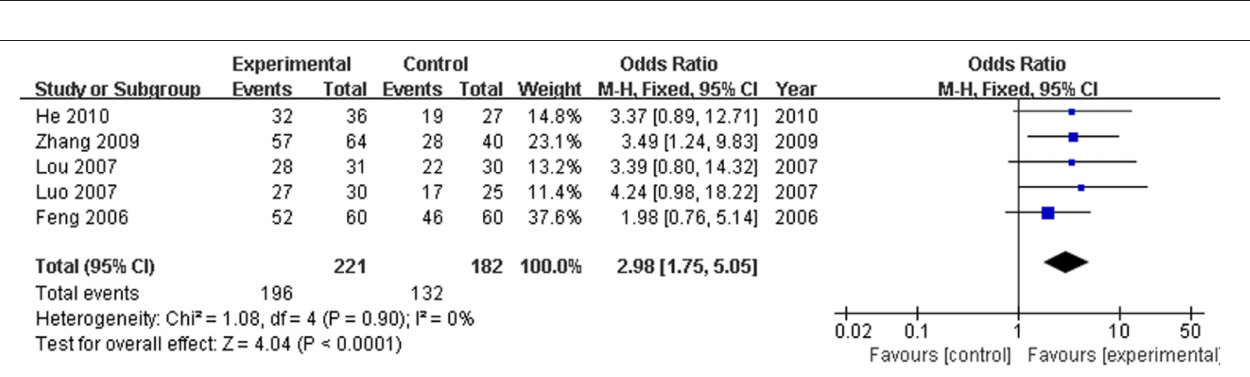
FIGURE 8 | Forest plot of high dose PRR relevant formulae with essential treatment vs. essential treatment in hyperbilirubinemia patients with hepatitis B. (1) Study item displayed as the first author with the publication year. (2) Specific analysis was performed for hepatitis B virus patients with hyperbilirubinemia. (3) I-squared and P are the criterion of the heterogeneity test, (cid:7) pooled odds ratio, — (cid:4) — odds ratio, and 95% confidence